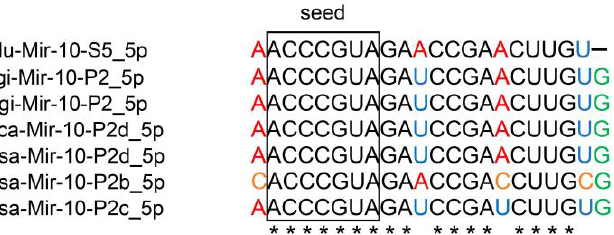
Figure 2. MIR-10 family miRNAs alignment. The seed plot is marked with a rectangle. The differences in the sequences are highlighted by color. Species designations: has- H. sapiens , Hlu- H. lucorum , Lgi- L. gigantea , Cgi- C. gigas , Aca- A. californica . Alignments for some other miRNAs of the MIR-10 family are presented in Supplementary File S3. * indicates top conserve nucleotides.